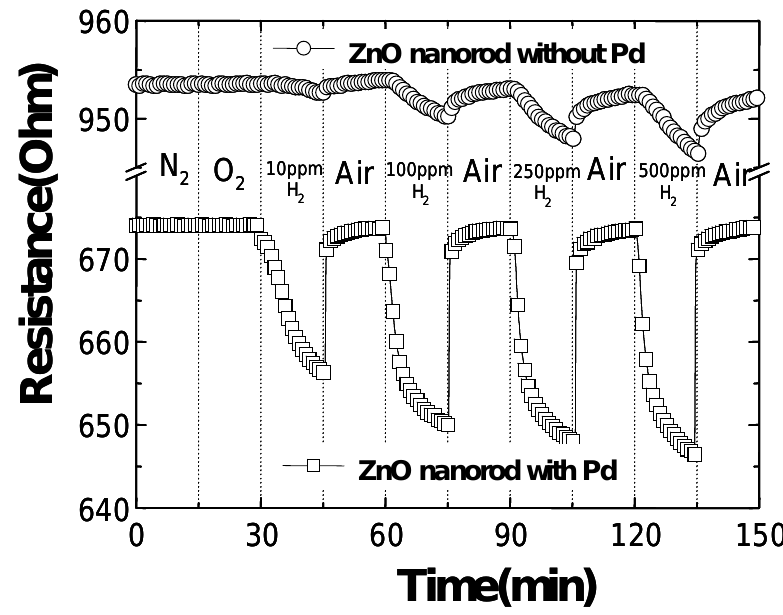
Figure 10. Time dependence of resistance of either Pd-coated or uncoated multiple ZnO nanorods as the gas ambient is switched from N proceeds. There was no response to O